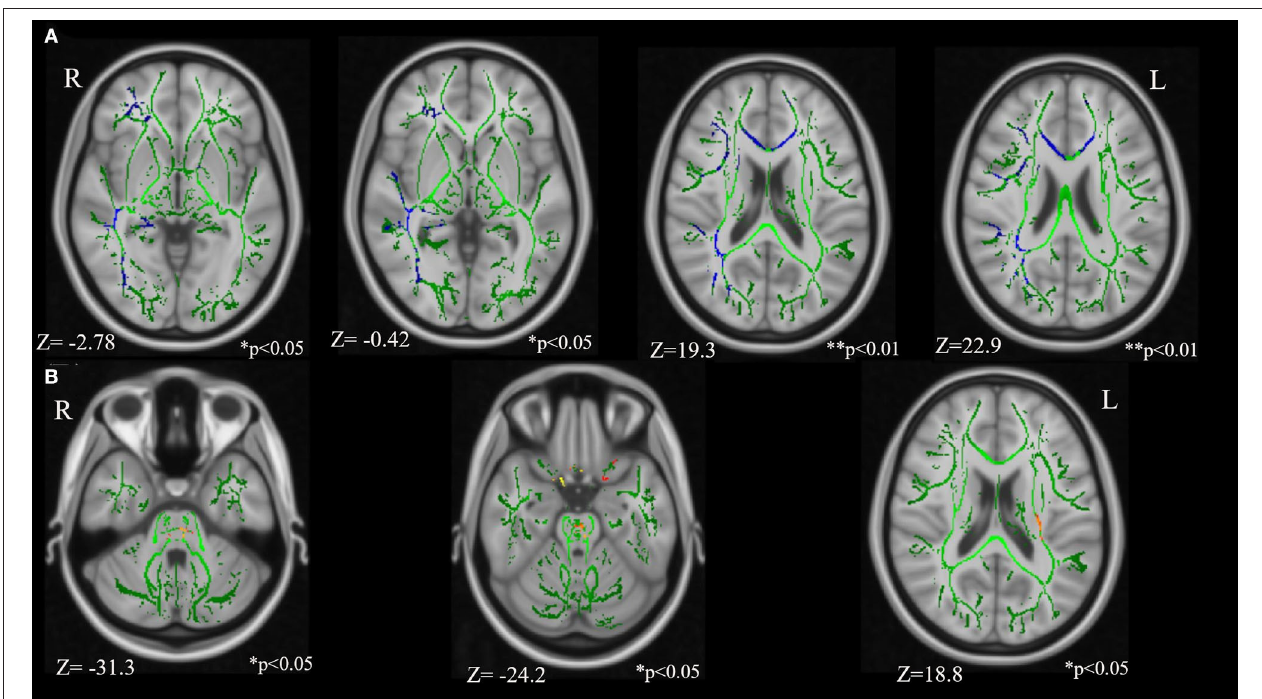
FIGURE 2 | Results of the tract-based spatial statistics revealed significant differences between the TSC and control groups in fractional anisotropy (FA). (A) Axial slices of mean FA skeleton (green) represent areas of no significant difference between groups. Regions in blue indicate areas where the value of FA is significantly lower in the TSC group (TSC < Control); right IFOF**, right SLF**, genu of CC*, right UF*, and right ILF*. (B) Regions in yellow/orange/red indicate areas where the value of FA is significantly higher in the TSC group (TSC > Control); pontine crossing tract*, bilateral CST*. FWE corrected, p < 0.05, with a cluster size of voxels > 10. Results are adjusted for age and sex. ** p < 0.001, * p < 0.05. IFOF, inferior frontal occipital fasciculus; SLF, superior longitudinal fasciculus; ILF, inferior longitudinal fasciculus; UF, uncinate fasciculus; CST, corticospinal tract; FWE, family wise error.